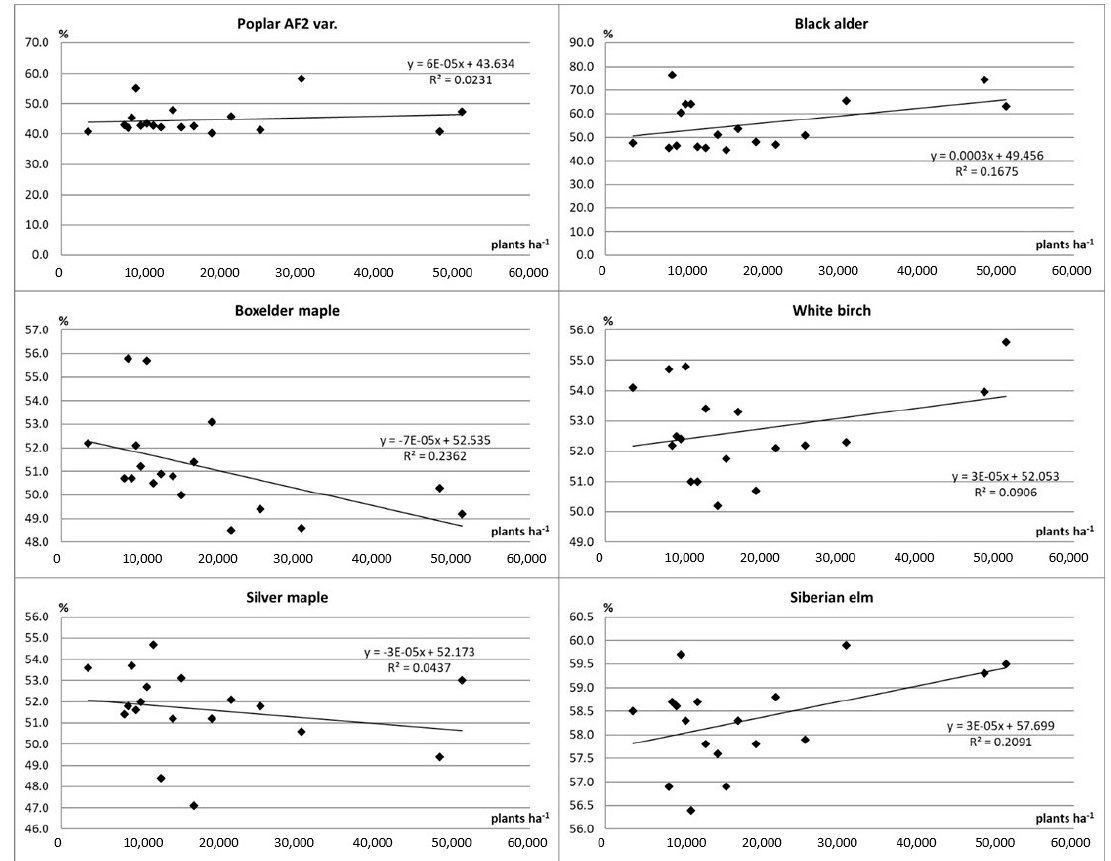
Figure 4. Relationship between dry mass share (%) and planting density (plants ha − 1 ).